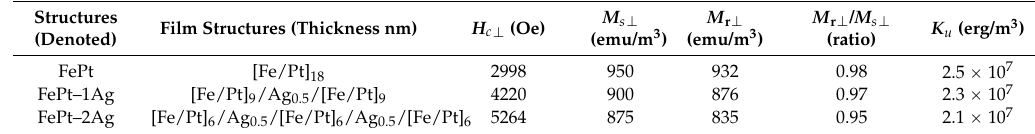
Table 1. Out-of-plane coercivity ( H c K ) saturation magnetization ( M s K ), remanent magnetization ( M r K ), remanent squareness ratio ( M r K / M s K ), and uniaxial magnetic anisotropy energy ( K u ) values for the [Fe/Pt] 18 multilayer films without and with the insertion of a single and two ultrathin Ag (0.5 nm each)